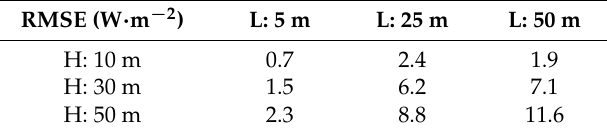
expressed in W · m − 2 at